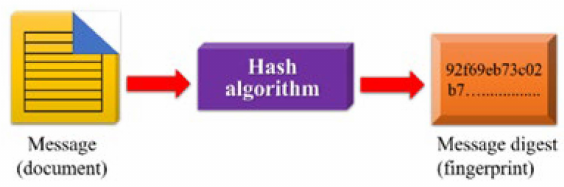
Figure 4. The communication and condensation.